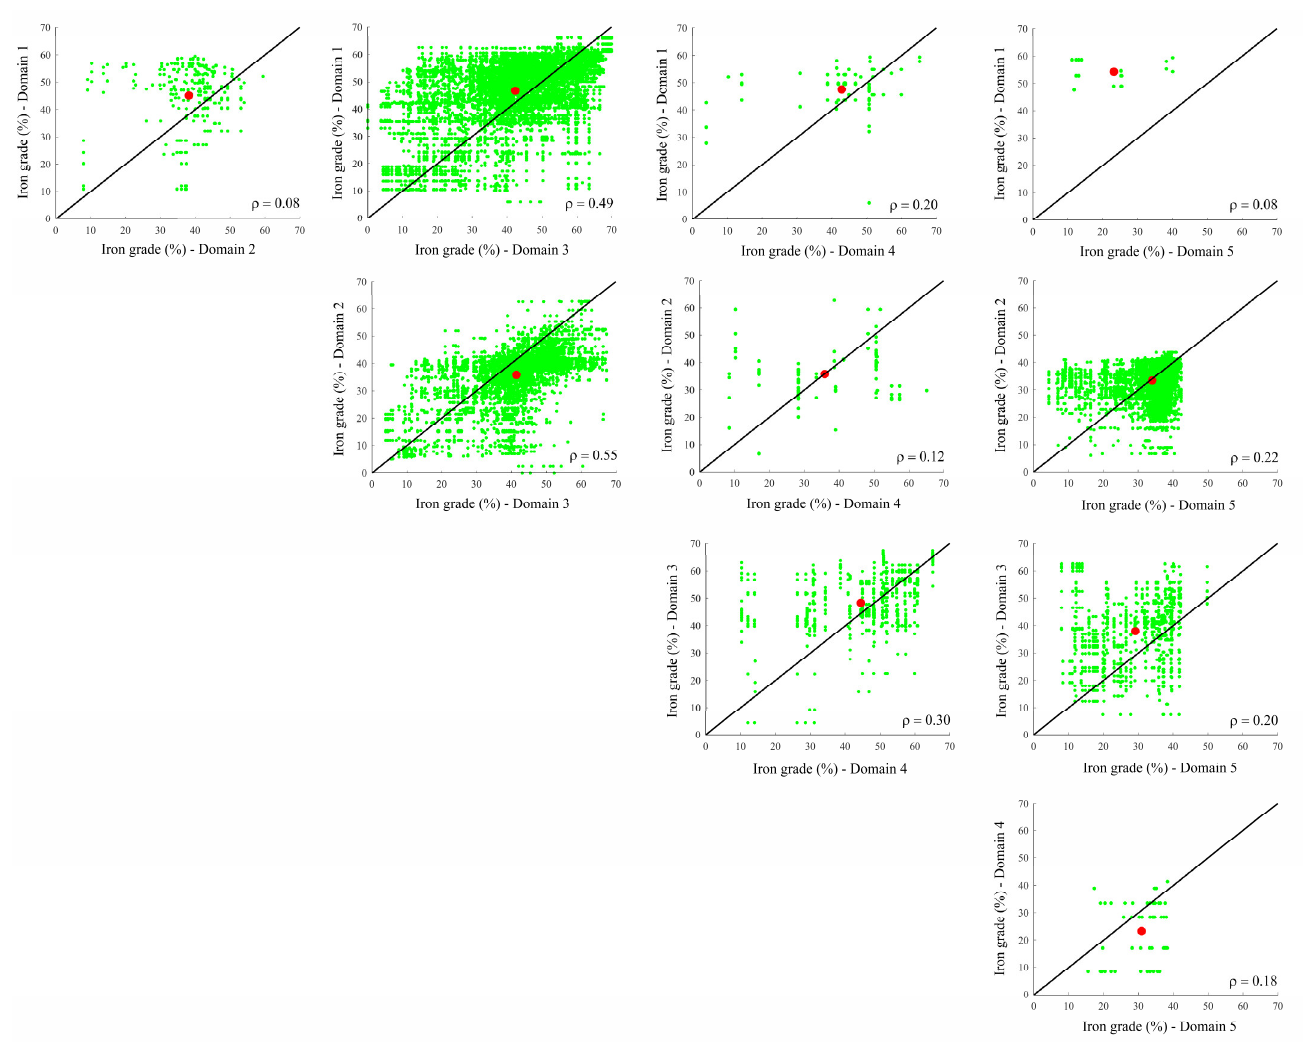
Figure 3. Omnidirectional lagged scatter plots. The coordinates of the green points are the iron grades at data points located in two different domains at a distance of less than 40 m, hence being close to the domain boundaries. The red point represents the gravity center of the scatter plot. The identity line is represented in black, and the correlation coefficient r is indicated for all scatter plots.